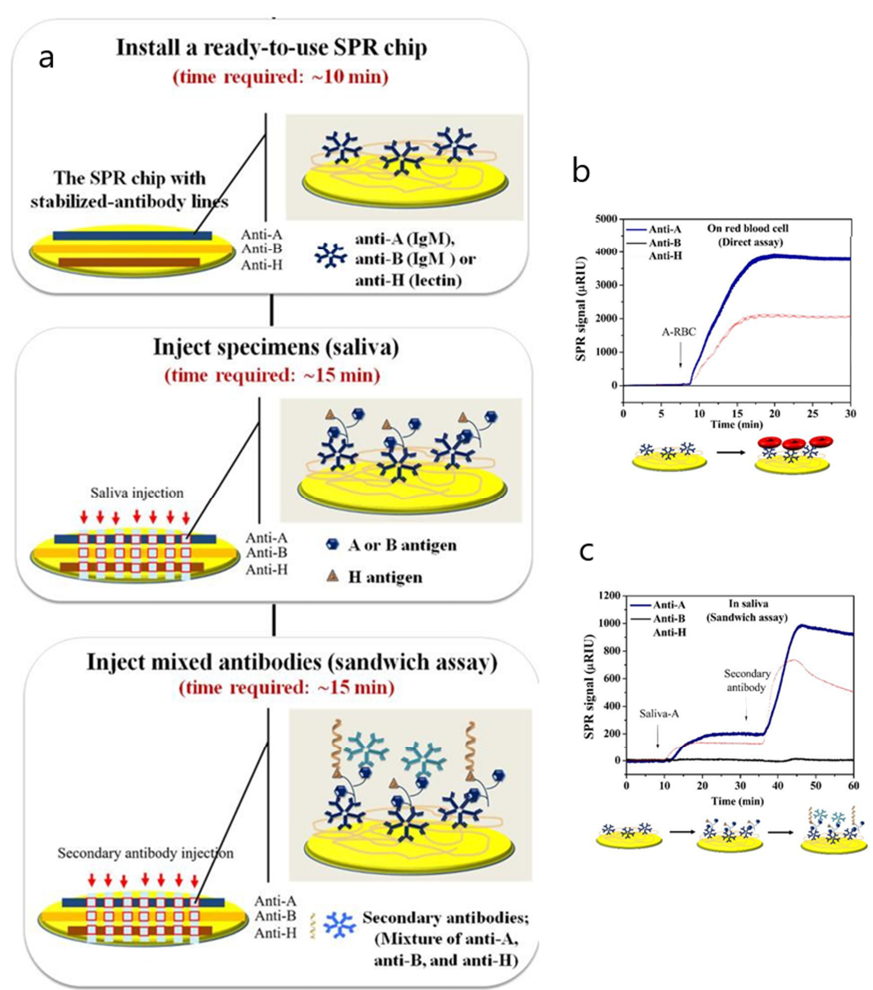
Figure 9. ( a ) SPR procedure for ABH antigen detection in saliva. ( b , c ) SPR sensorgrams of ABH antigen detection in red blood cells (direct assay) ( b ) and saliva (sandwich assay) ( c ). Adapted with permission from Peungthum et al. [94] (Copyright (2017) © Royal Society of